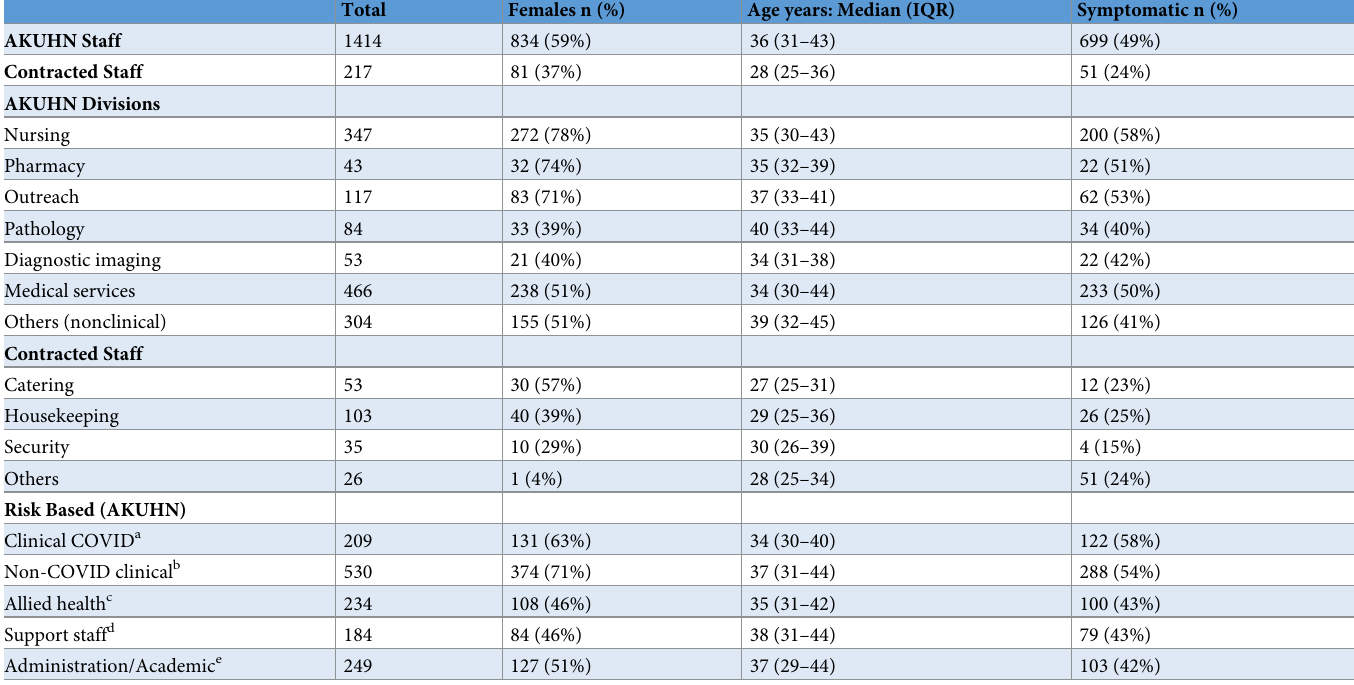
Table 1. Characteristics of study